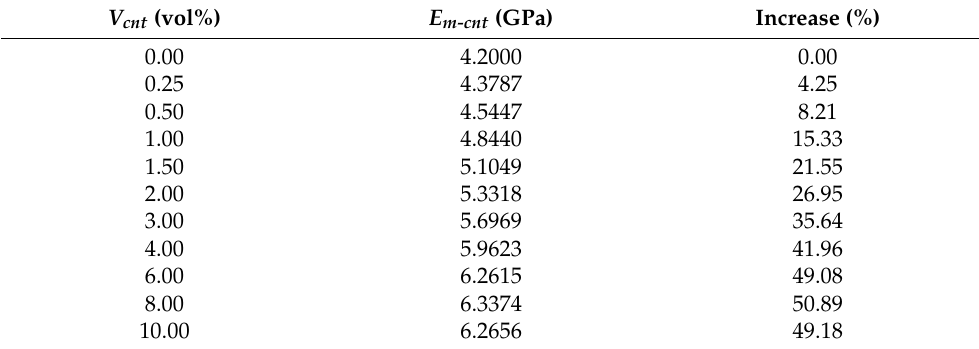
Table 7. Young’s modulus of CNT-reinforced matrix obtained from modified H–T model concerning orientation, waviness, and agglomeration factors for different V cnt values (vol%) ( E m = 4.20 GPa,